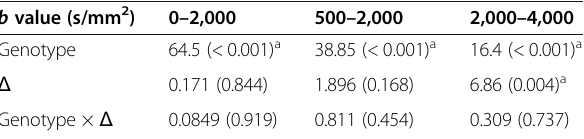
Table 2 Two-way ANOVA results ( F values and p values) for the ADC on the contralateral